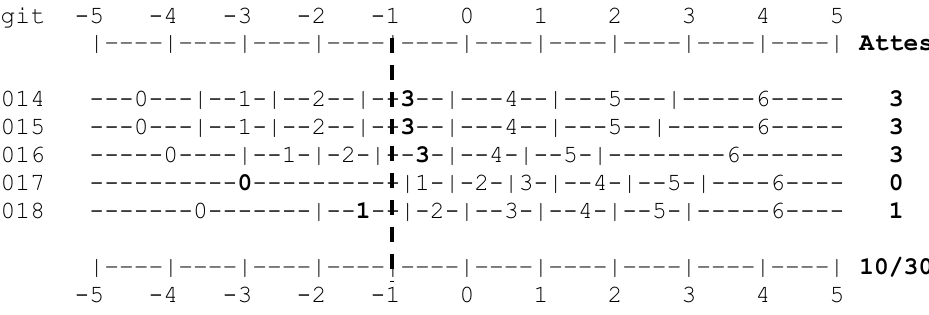
Figura 2 – Mappa delle categorie degli Items: in grassetto i punteggi attesi per un soggetto con abilità stimata pari a –1